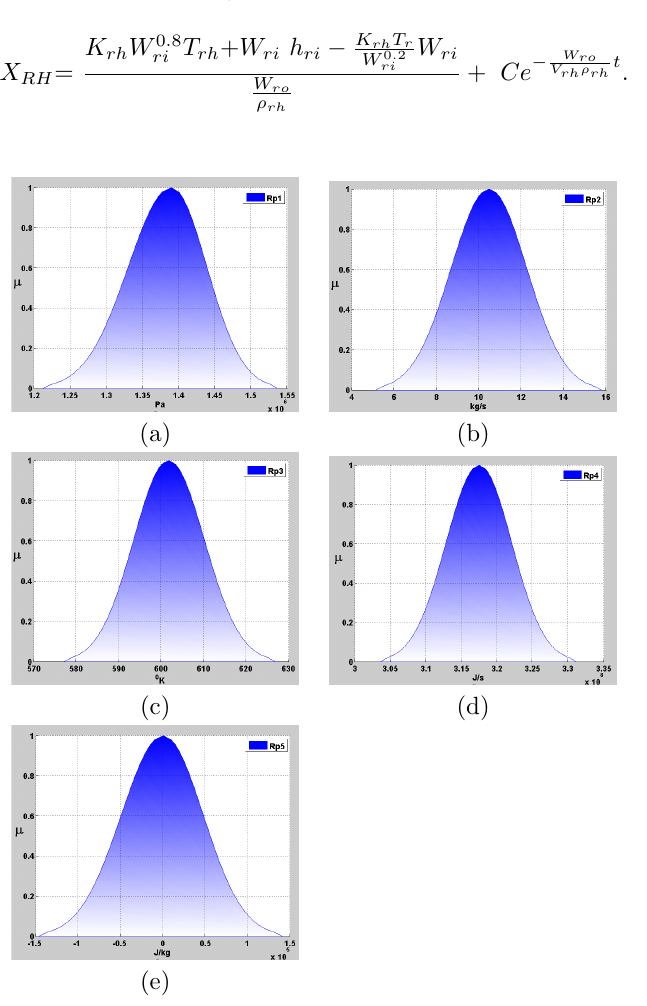
Figure 9. Fuzzy input parameters of reheater system (a) p 1 = P ri , (b) p 2 = W ri , (c) p 3 = T ri , (d) p 4 = Q rs and (e) p 5 = h